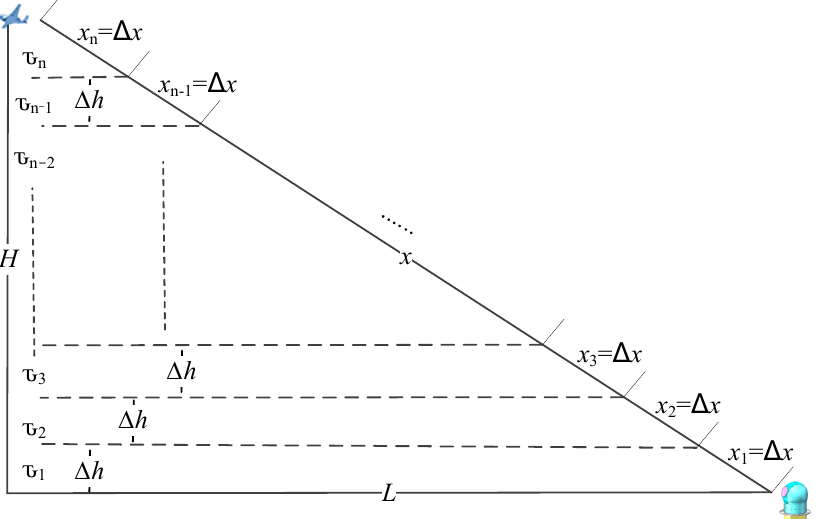
Figure 3. Schematic diagram of turbofan engine structure.